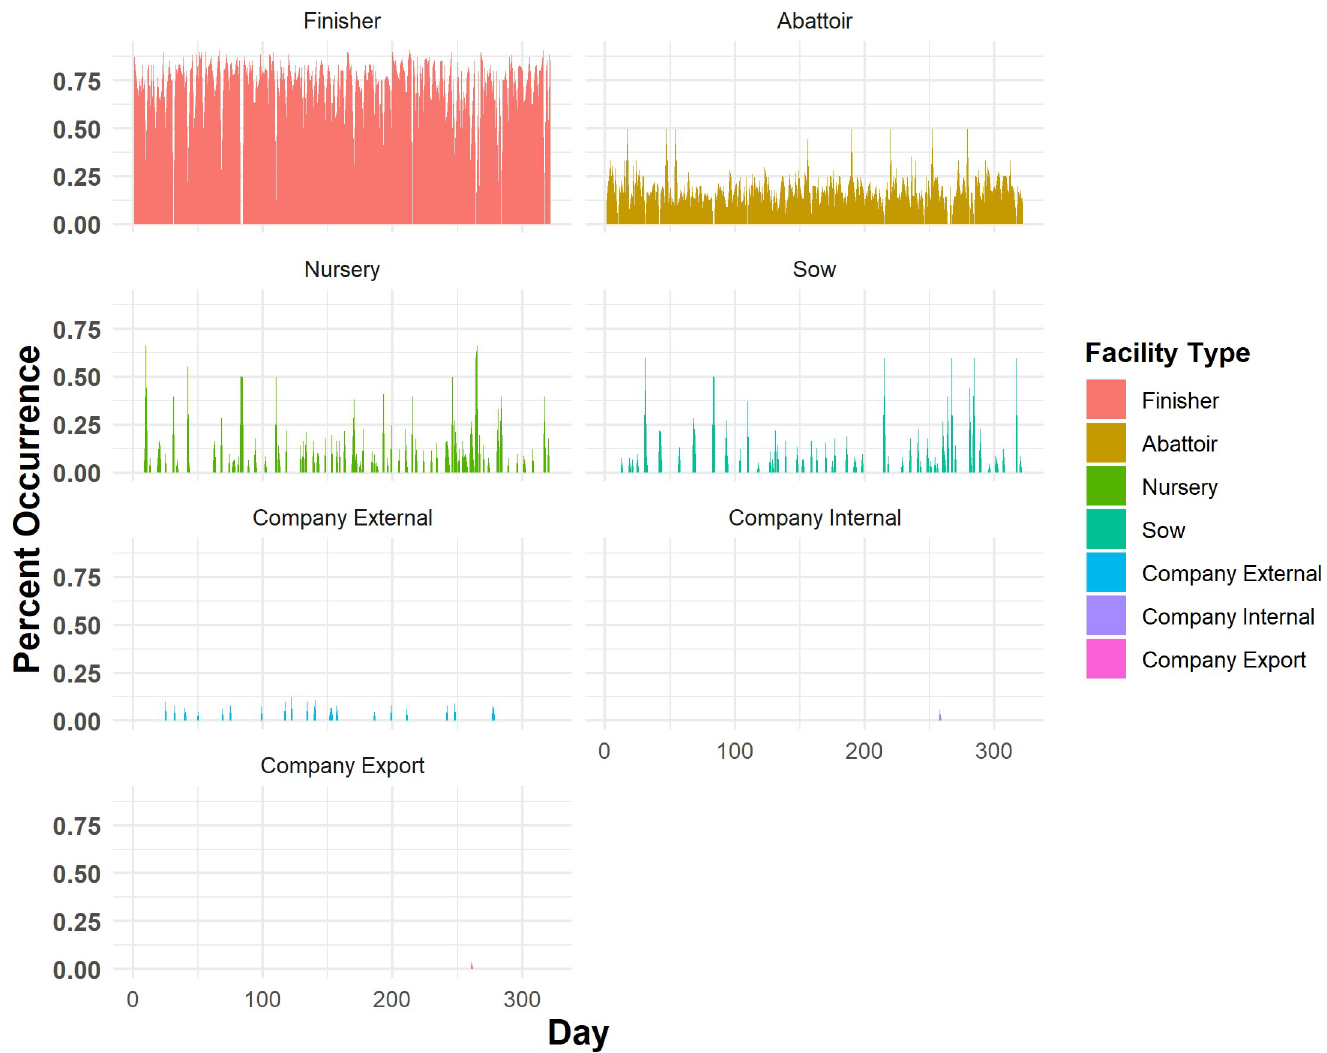
Fig 7. Daily one-mode network percent occurrence of facility types within the daily maximum weak